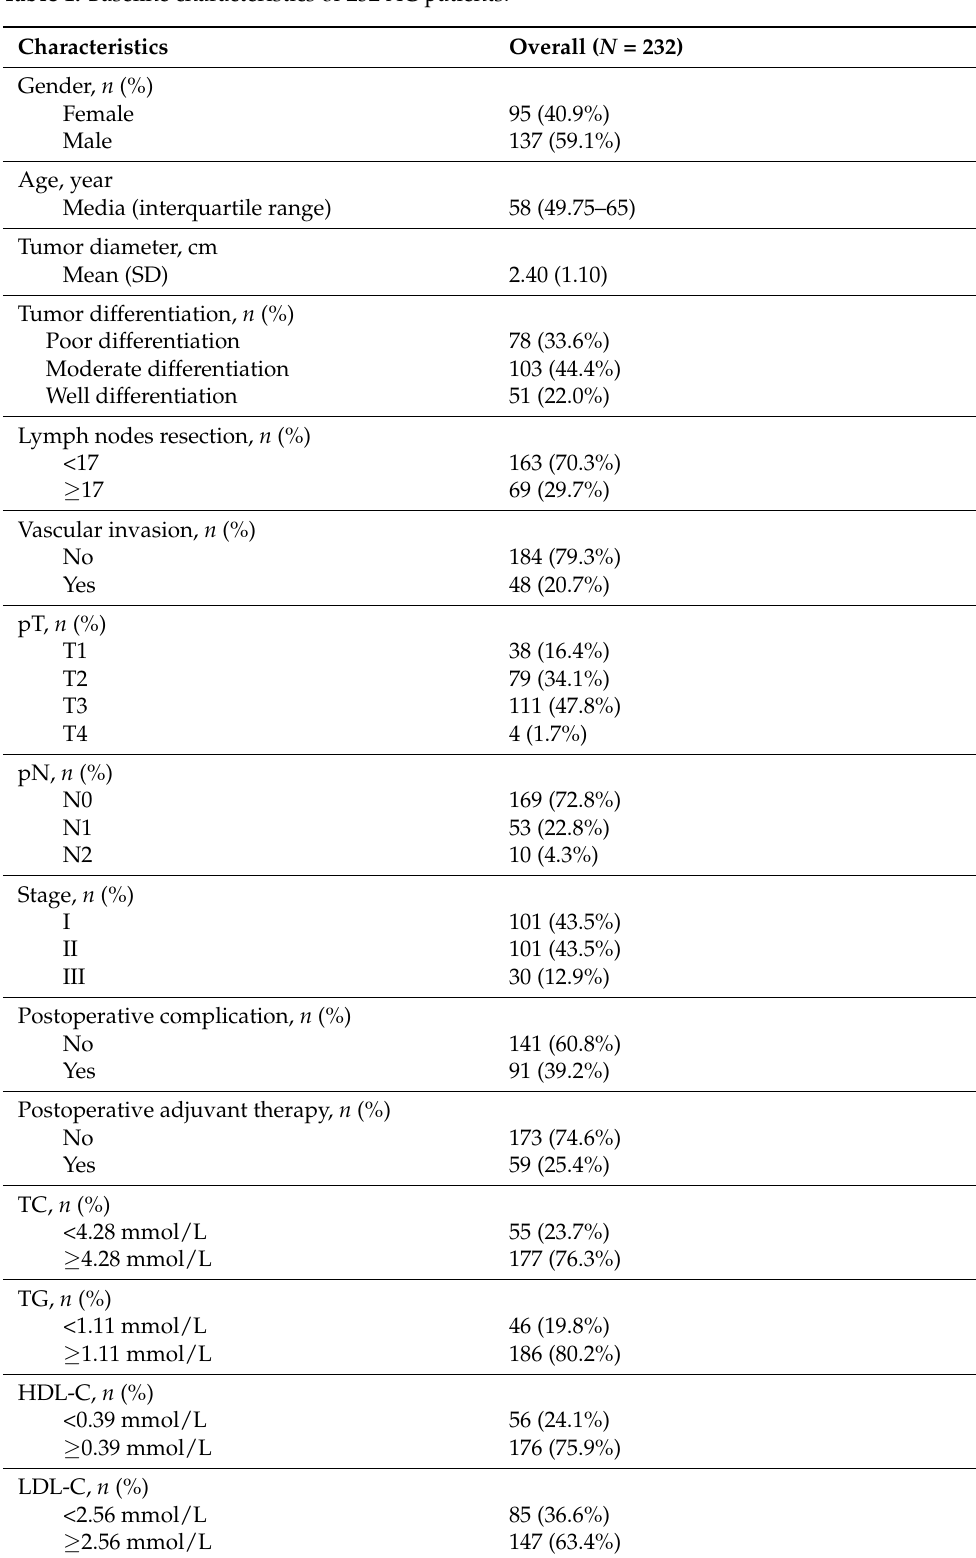
Table 1. Baseline characteristics of 232 AC